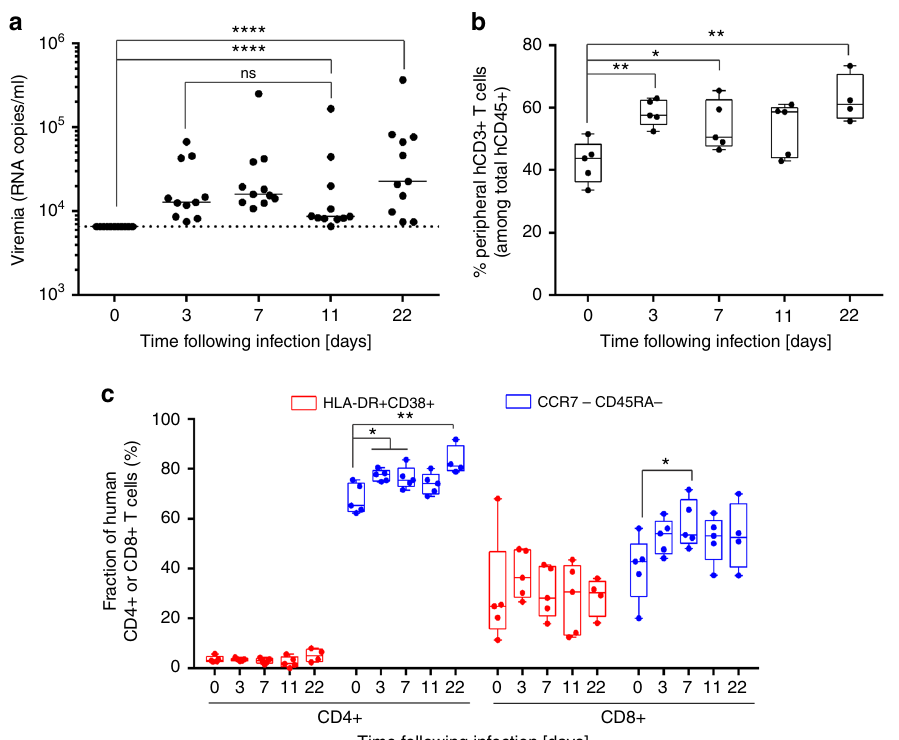
Fig. 1 NRG-HIS mice do not clear YFV-17D infection. a YFV-17D serum viremia in the peripheral blood of NRG-HIS mice over the course of infection. ( + ) RNA copies per ml were quanti fi ed by RT-qPCR. Limit of detection (dotted line) is shown. Horizontal lines represent median viremia at each time point ( n = 12). **** p ≤ 0.0001, ns non-signi fi cant (Wilcoxon – Mann – Whitney test). b Percentage of peripheral human CD3 + T cells among the total human CD45 + cell population in the blood of NRG-HIS mice over the course of YFV-17D infection. Bounds of box and whiskers represent the min-to-max fraction of